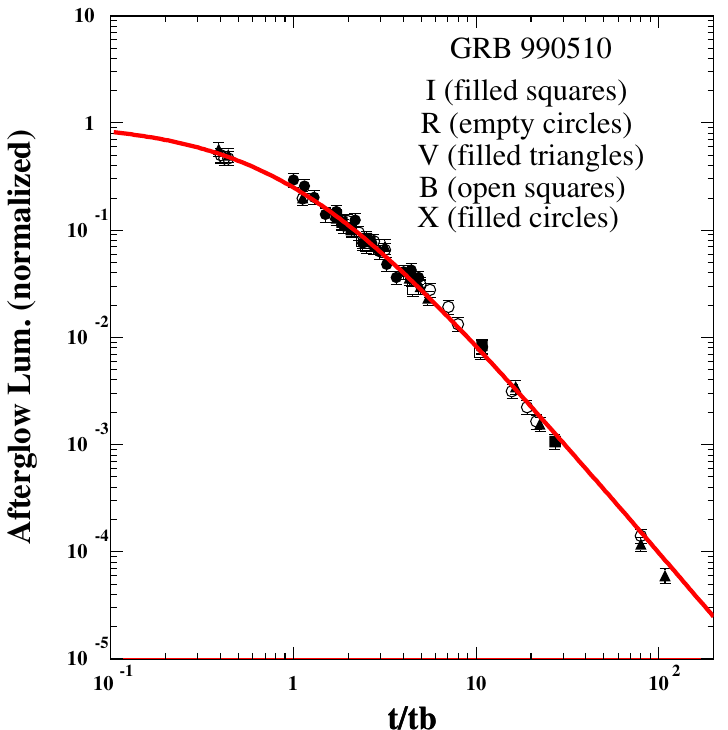
Figure 19. Comparison between the normalized light curves of the X-ray and optical AGs of GRB990510 and their universal shape: Equation (19). The data are the same as in Figure 18.